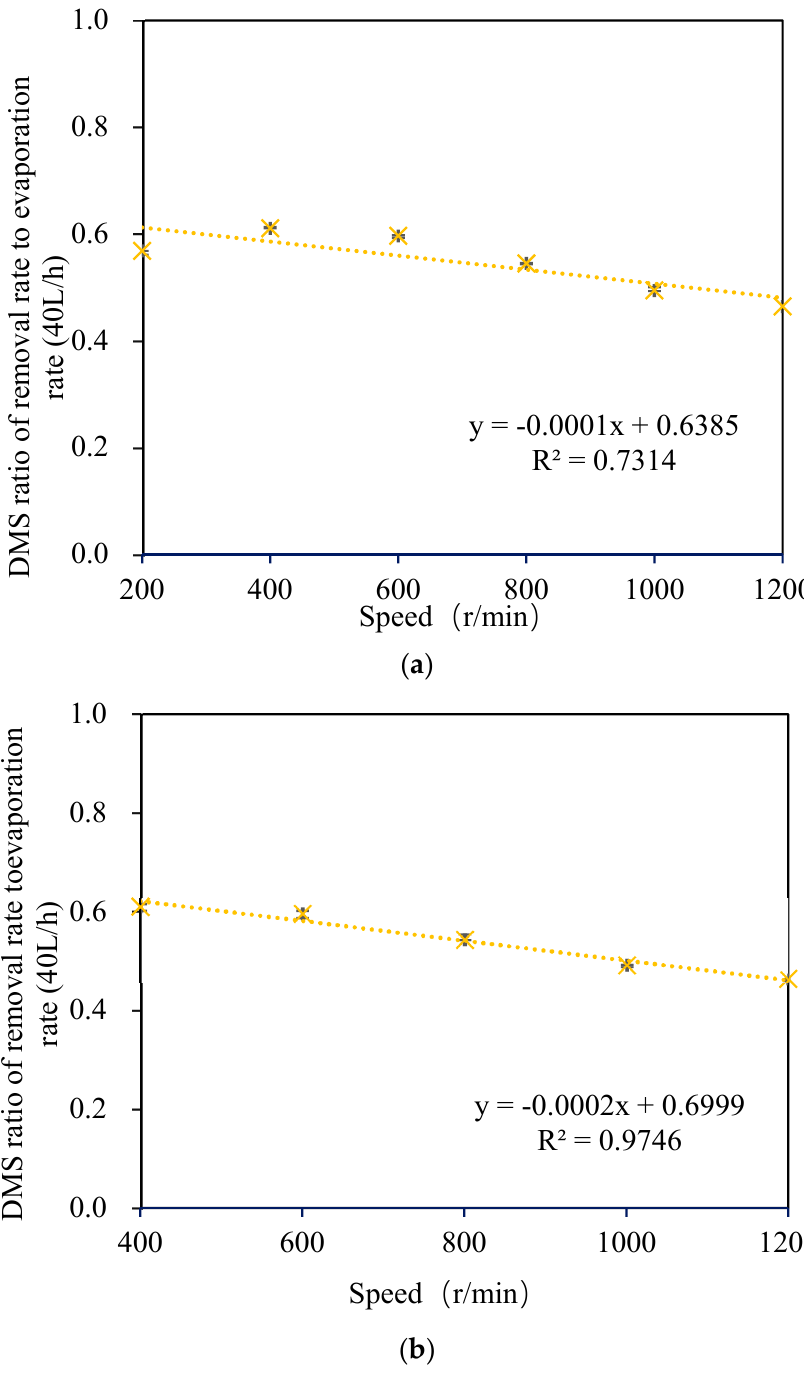
Figure 7. Variation of the ratio of the DMS removal rate to the wort self-evaporation rate with the rotating speed: ( a ) 200 − 1200 r/min; ( b ) 400 − 1200 r/min.